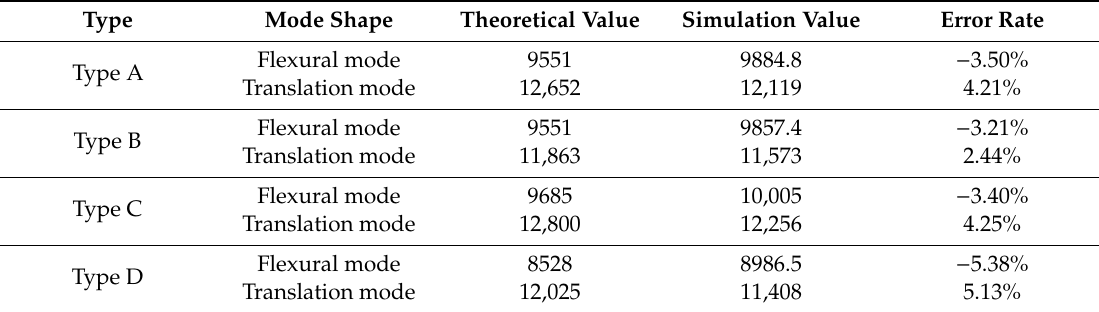
Table 5. Comparison of theoretical and simulation values of types A, B, C, and